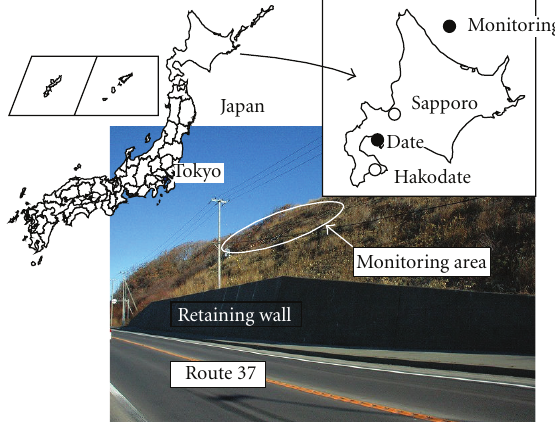
Figure 2: Location of monitoring site in Date,